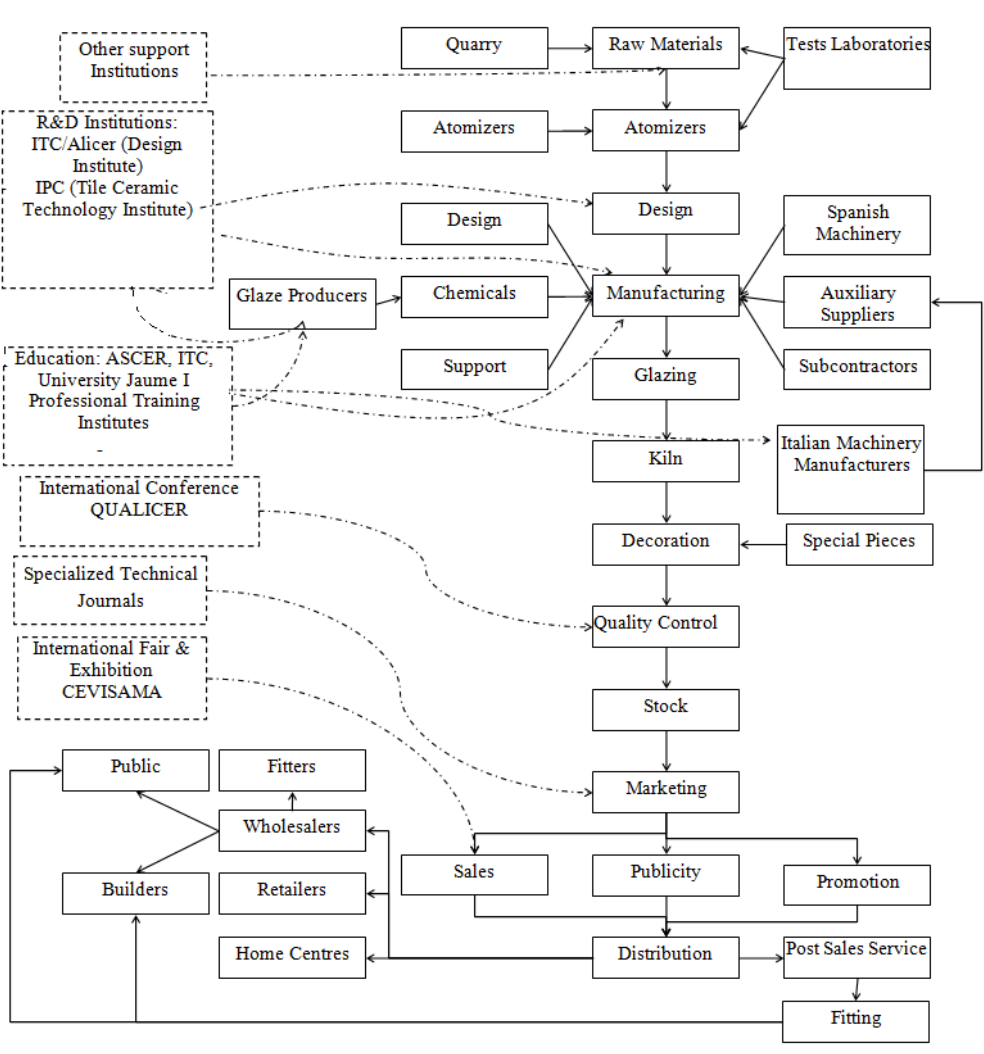
Figure 1. Actors and agents in the value chain of the Spanish ceramic tile cluster